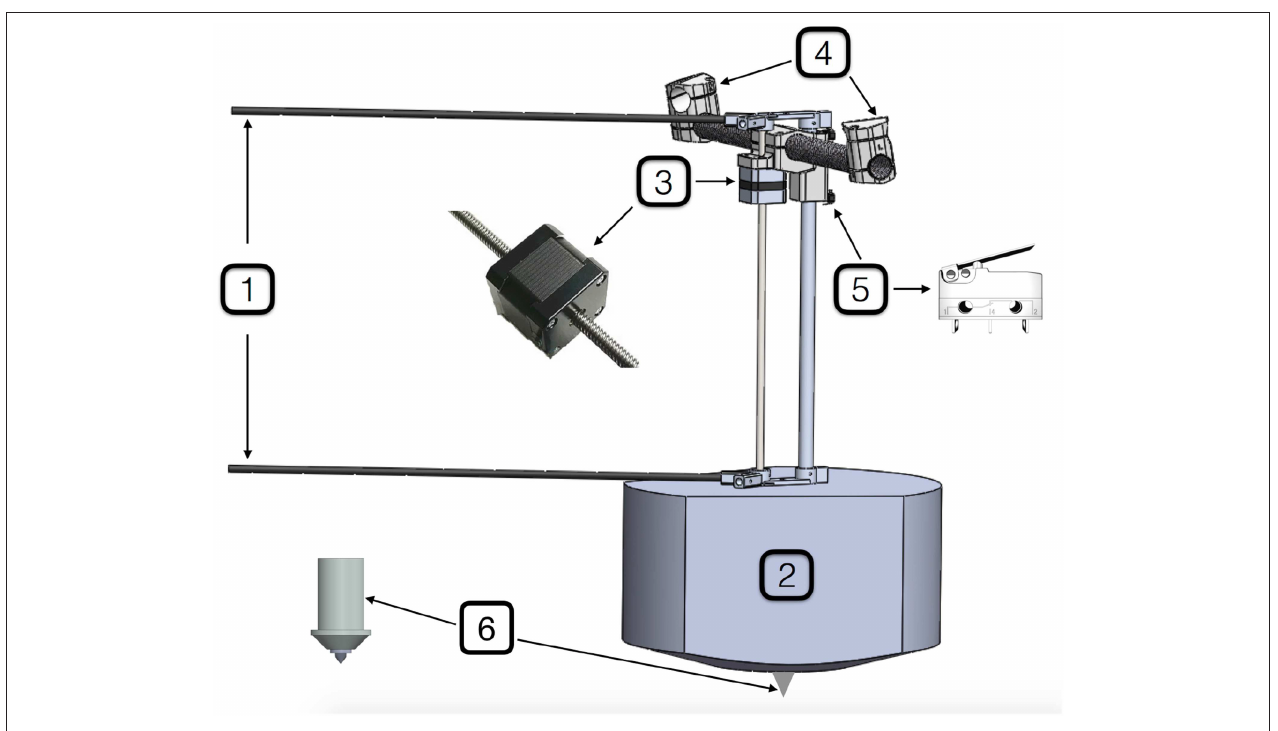
FIGURE 5 | The custom landing gear with the following components labeled: 1. carbon fiber stabilizing rods; 2. foam flotation; 3. hollow axle stepper motors move the drill system up and down threaded lead screws; 4. 3D printed clamps used to attach the landing gear to the drone; 5. Microswitches that define the vertical range of motion; 6. stainless steel